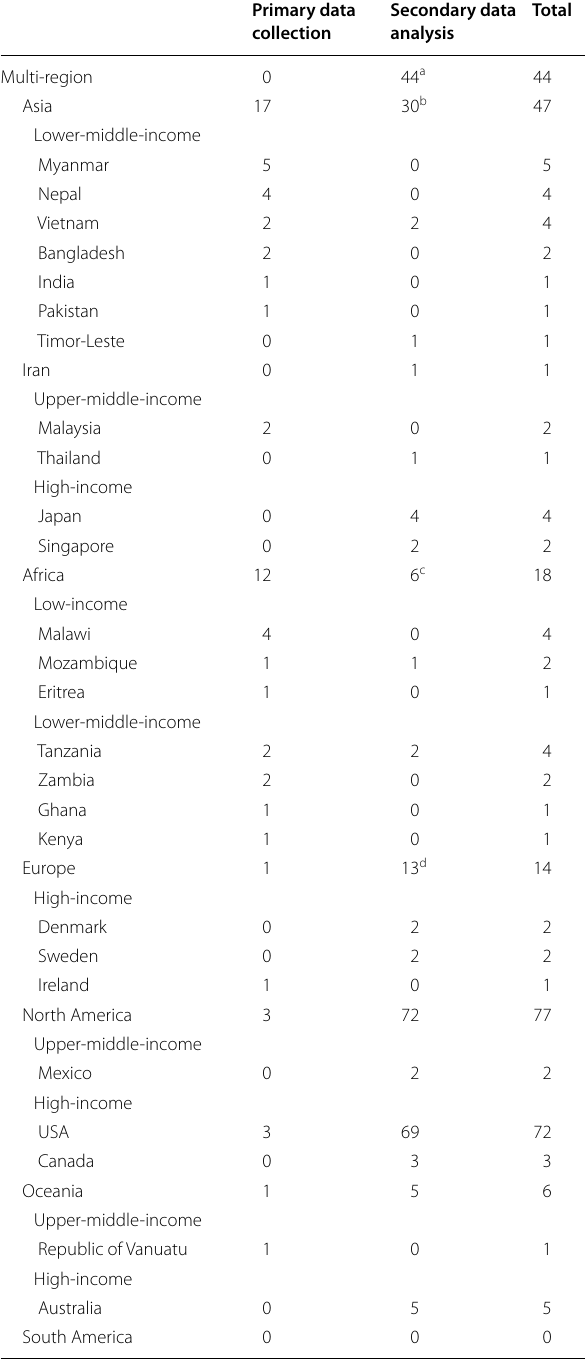
Table 1 The number of papers by region and